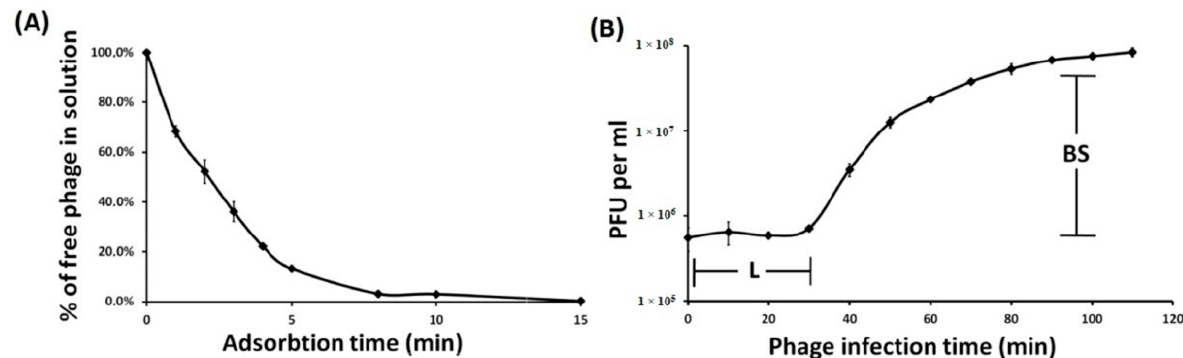
Figure 2. Infection analysis of phage TaPaz. Adsorption assay ( A ) and one-step growth curve ( B ) of phage TaPaz on A. baumannii NIPH601 with the indication of estimated burst size (BS) and latent period (L). Results are the means and standard deviations from three independent experiments. PFU: plaque-forming units.